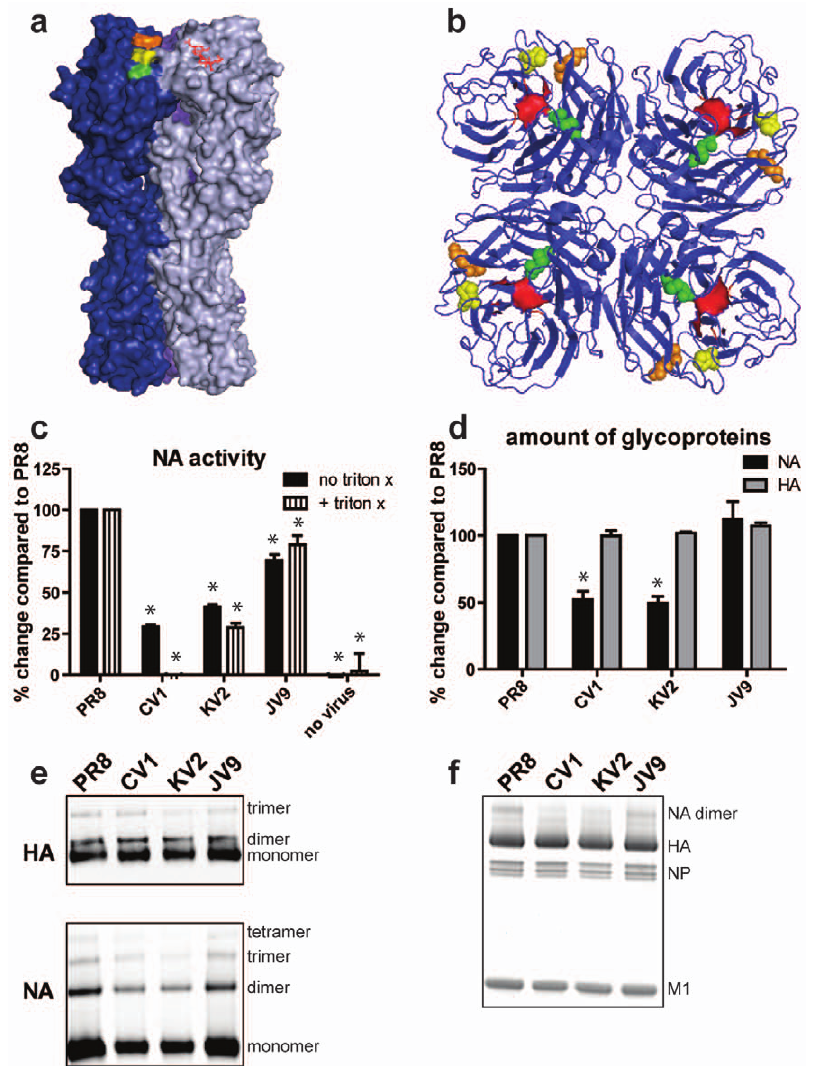
Figure 1. Compensatory NA mutations decrease NA activity. Three-dimensional view of HA trimer (a) and NA tetramer (b). Mutations found in individual viruses are in different colors (yellow=CV1, orange=KV2, green=JV9). Sialic acid (a) and the NA active site (b) are shown in red. (c) NA activities of viruses + / 2 Triton-X were determined using a colorimetric assay. The amount of glycoproteins incorporated in purified virions was determined by ELISA (d), western blots (e), and total protein blots (f). *, p , 0.05 compared to